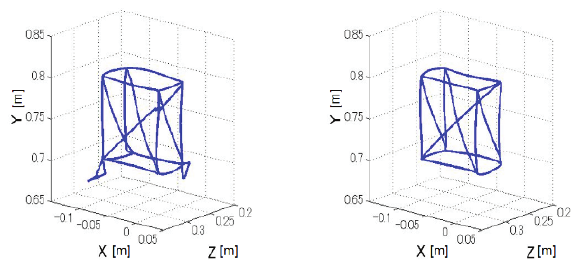
Figure 13. Task space trajectory of the tip of the L-shaped tool during the test movement, after motor babbling was performed first without